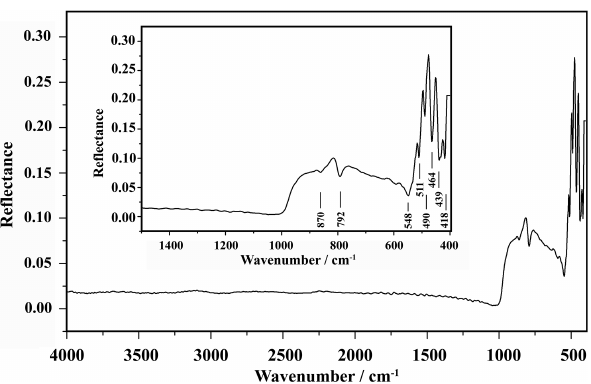
Figure 4. The Raman spectrum of liguowuite.